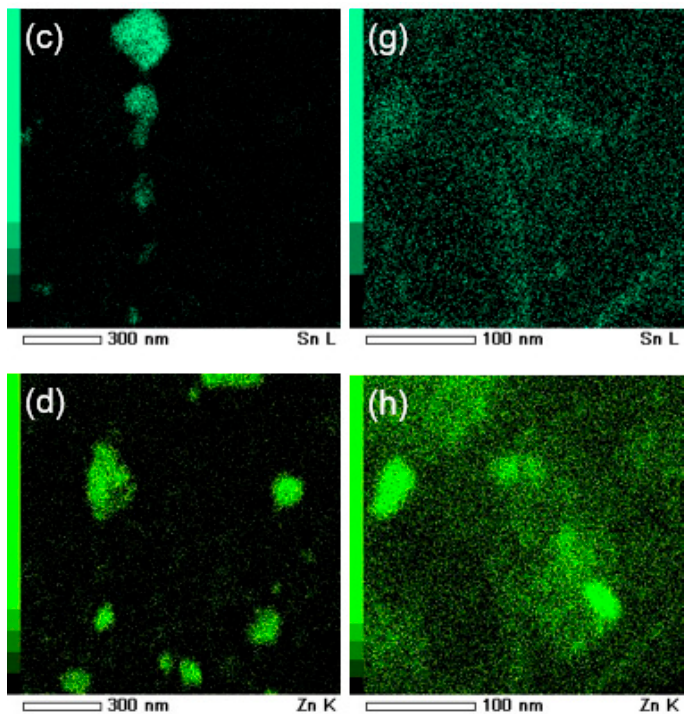
Figure 9. ( a , e ) Scanning transmission electron microscopy (STEM) bright-field image and corresponding EDS mappings with ( b , f ) Al, ( c , g ) Sn, and ( d , h ) Zn for Al-30wt %Sn-10wt %Zn powders after processing by HPT for N = 20.